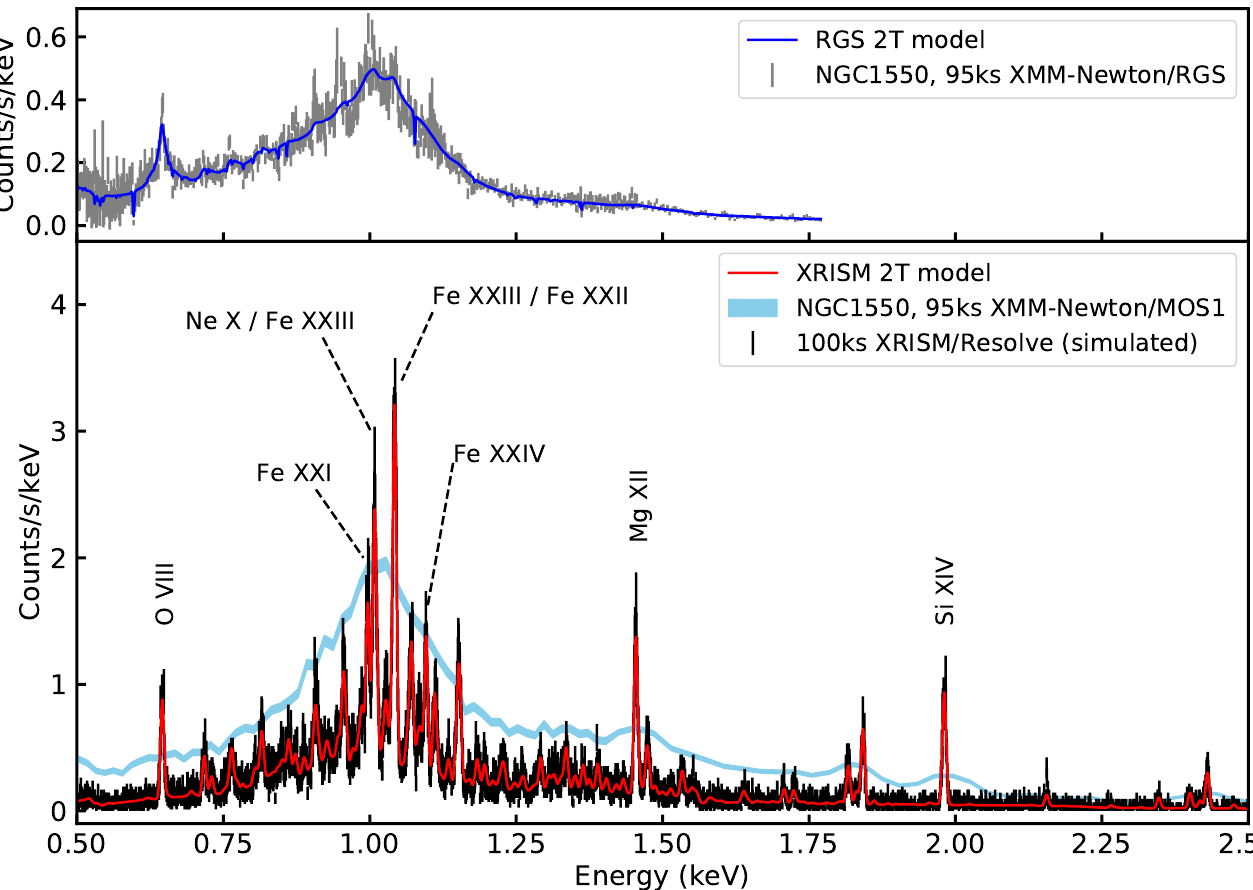
Figure 13. A comparison between existing archival XMM- Newton data of the central regions of the galaxy group NGC1550, and predictions for XRISM / Resolve using a similar exposure time and spectral model. ( Top panel ) The RGS spectrum extracted from a 3.4 arcmin-wide stripe in the cross-dispersion direction; spectra from RGS1 and RGS2 and from the three different existing observations have been stacked for display purposes (for details of the data reduction, see Reference [322]). The blue curve shows the best-fit 2T model using SPEXACT v3.0.6, including the effect of line broadening due to the extent of the source. ( Bottom panel ) The XMM- Newton -MOS1 spectrum from the central 0.05 r 500 region of NGC1550 (adapted from Reference [128]) is shown in blue. This region roughly corresponds to the FoV of XRISM / Resolve . In red, we show the predicted model obtained by re-scaling the 2T RGS model from the top panel to match the XMM- Newton - MOS1 flux, and folding this through the XRISM / Resolve response. This re-scaling is necessary because the absolute flux determined by XMM- Newton -RGS for an extended source is uncertain, since technically a region up to 10 arcmin along the dispersion direction can contribute to the observed count rate. A simulated 100 ks XRISM / Resolve spectrum using this model is shown in black. The 5 brightest Fe lines, and lines from all elements other than Fe with a line flux exceeding 5 × 10 − 17 photons/s/cm 3 , are